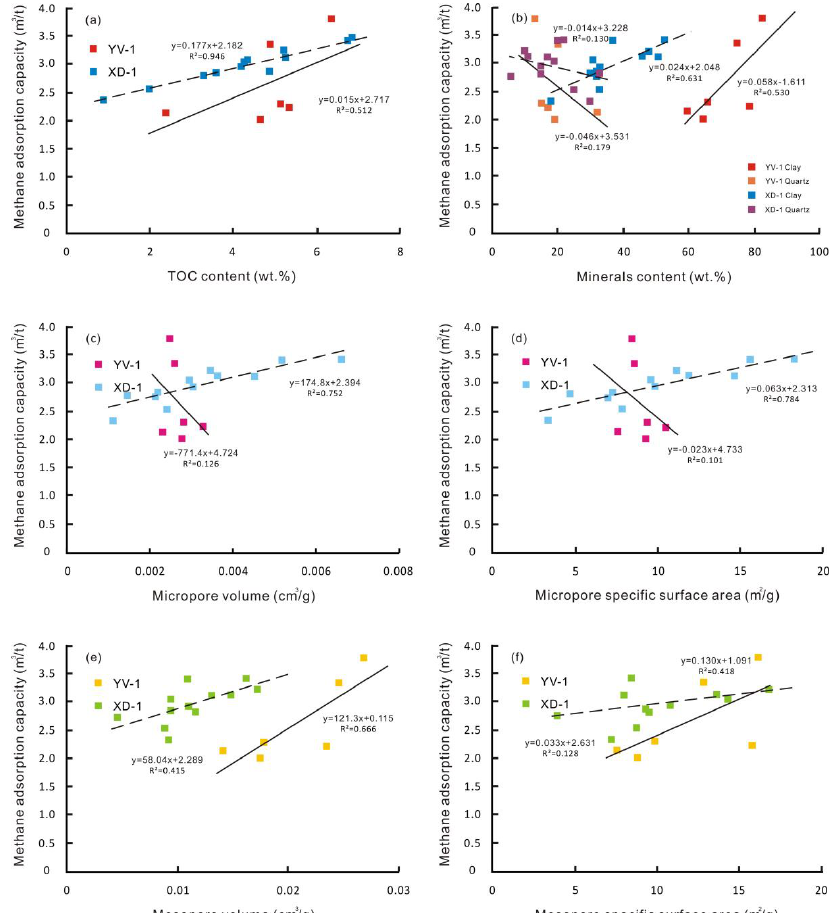
Figure 17. Relationships between methane adsorption capacity and TOC content ( a ), clay content ( b ), micro-PV ( c ), micro-SSA ( d ), meso-PV ( e ), meso-SSA ( f ) of transitional Longtan Shale samples from YV-1 and